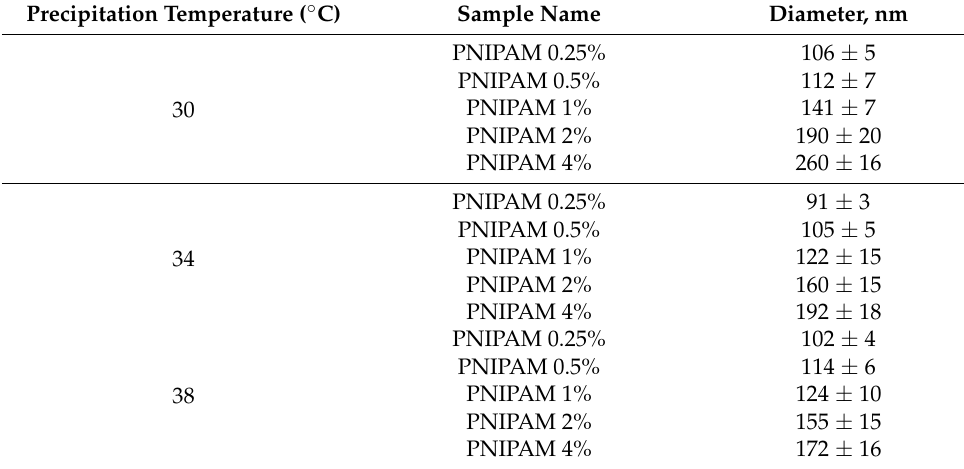
Table 2. Particle size of PNIPAM/magnetite nanoparticles by